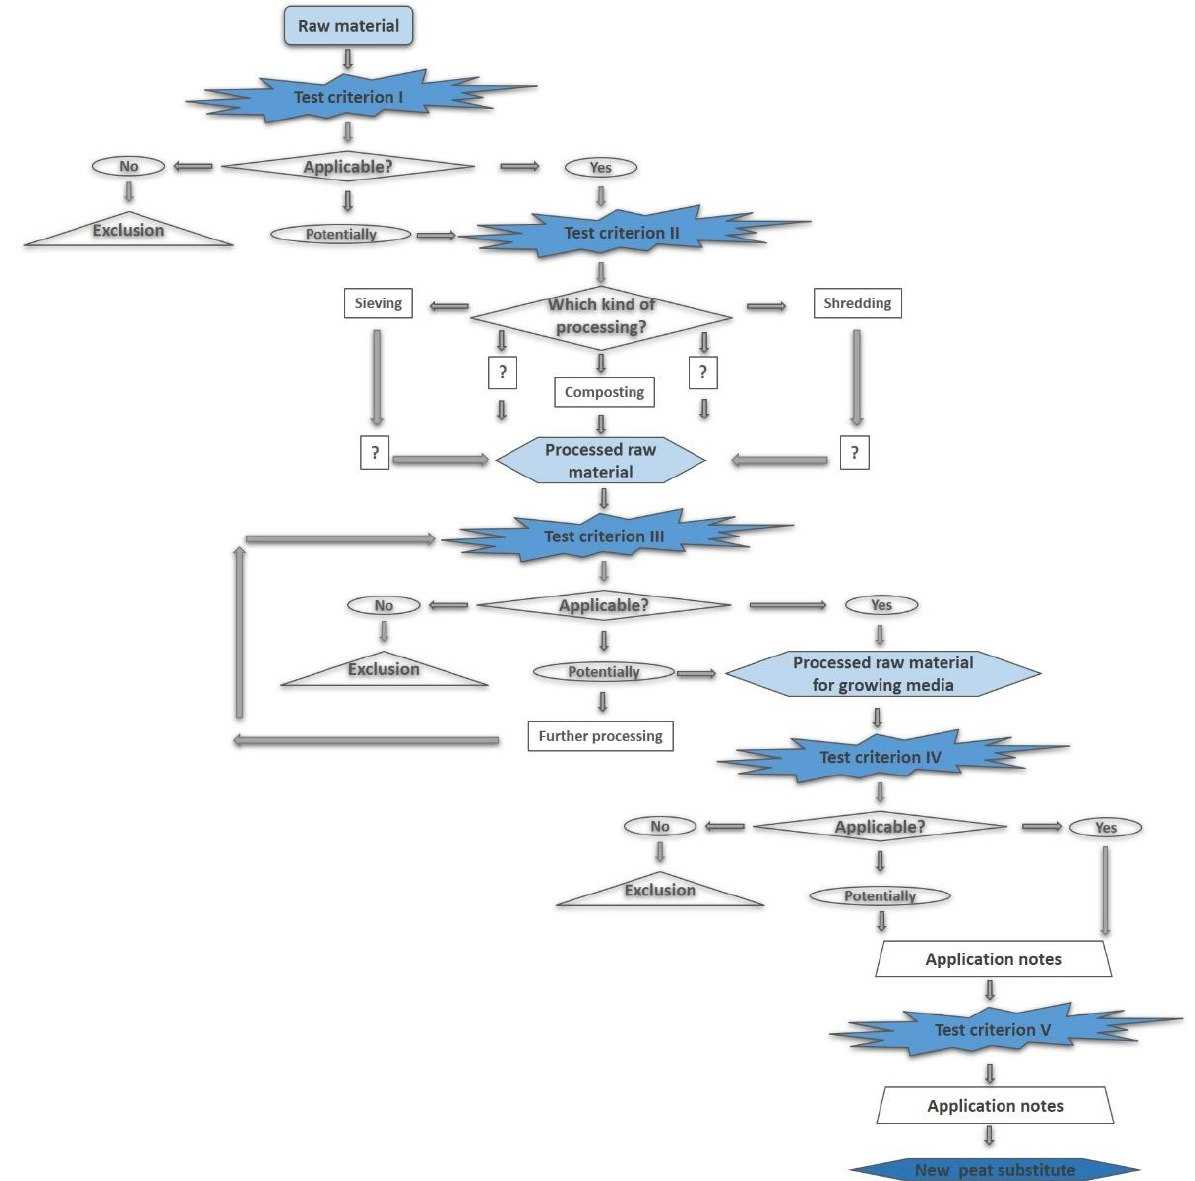
Figure 1. Decision tree for testing raw materials as potential components for growing media.